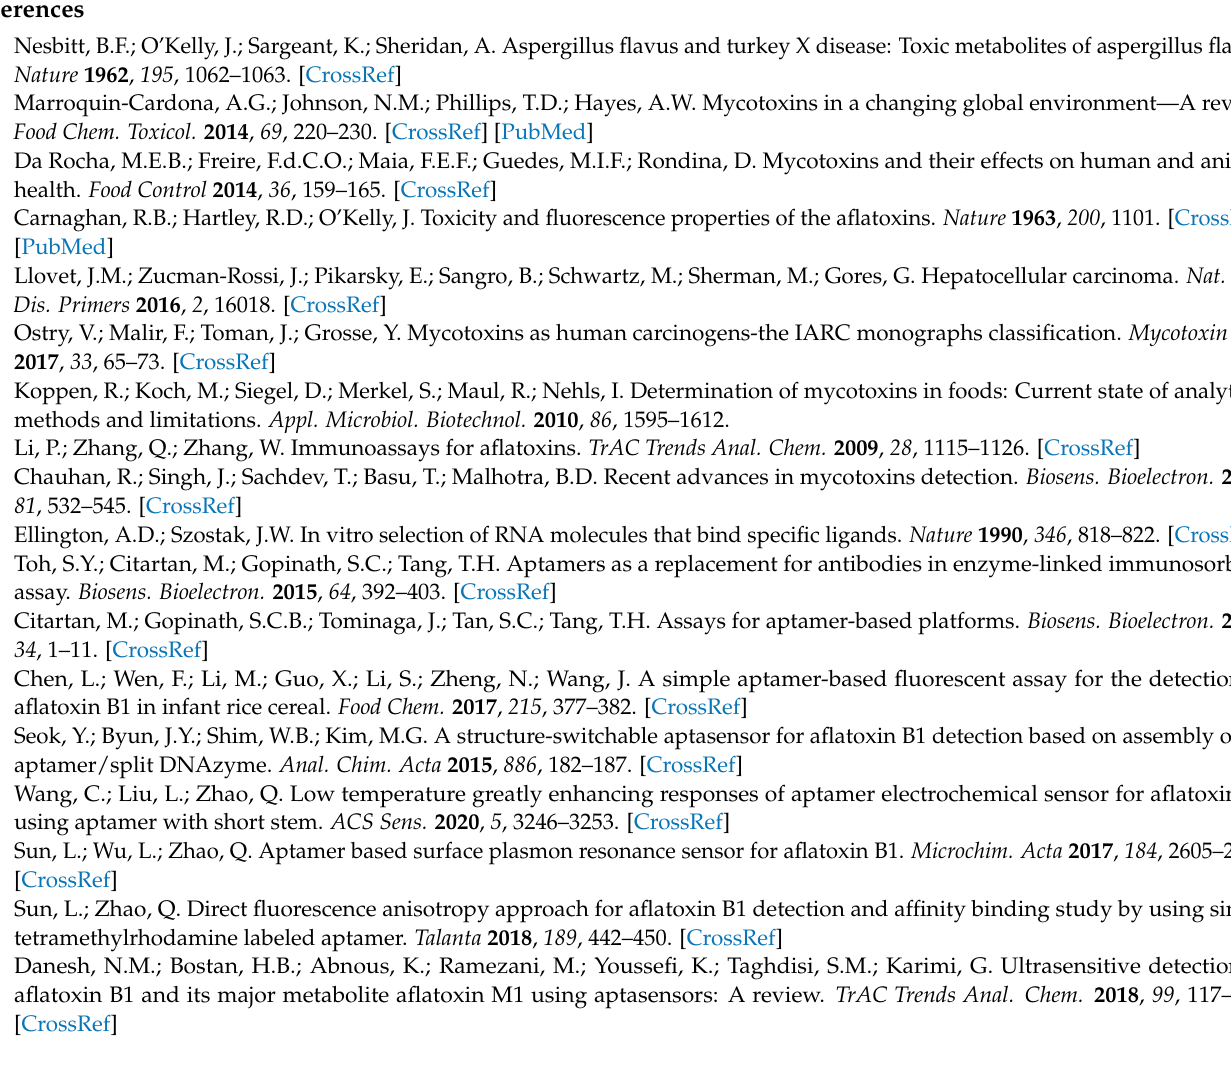
Figure S6. Selectivity of the fluorescent switch aptasensor towards AFB1; Figure S7. Detections of AFB1 spiked in 20-fold diluted beer and 20-fold diluted corn flour